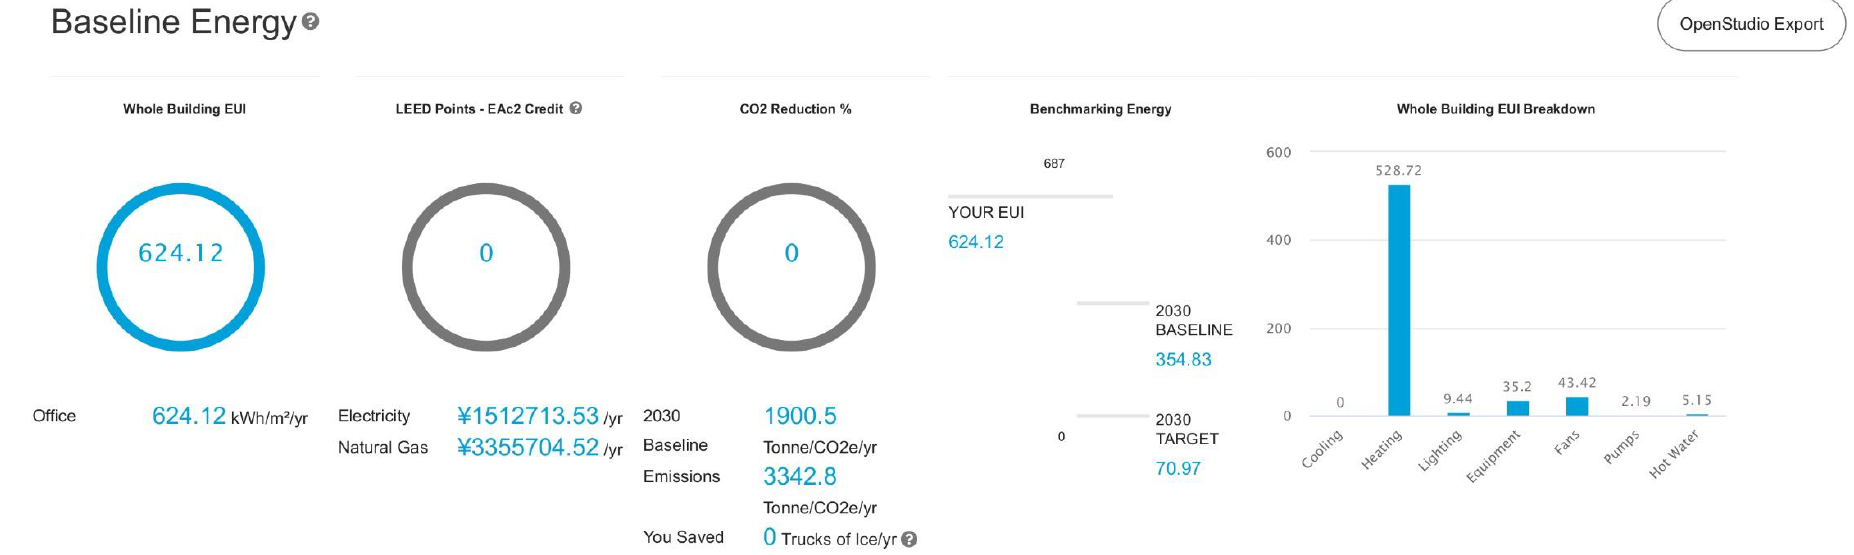
Figure A50. Zone 8-H Yushu, Qinghai (post-COVID-19 78% scenario).